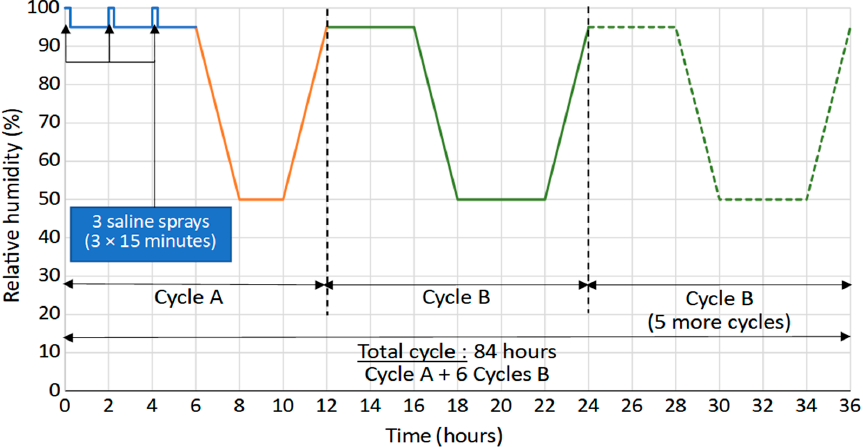
Figure 3. Relative humidity and cycles of the corrosion test.